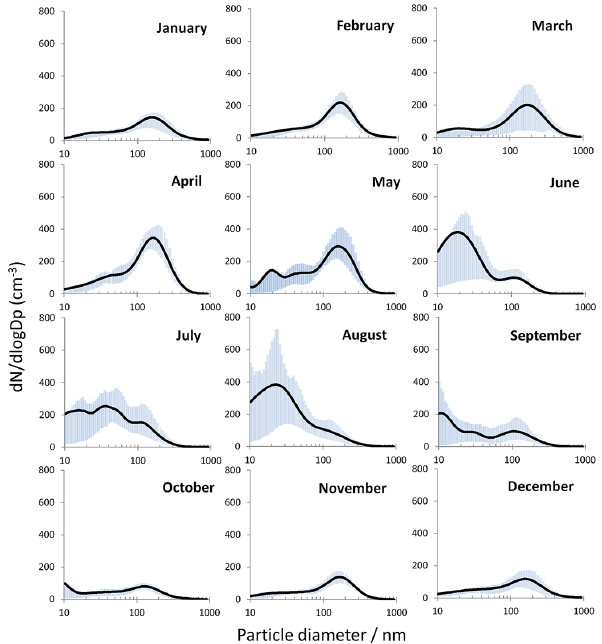
Figure 4. Monthly median particle number size distribution at Sta- tion Nord during 2012. The corresponding log-normal fitting pa- rameters are shown in Table 1. The shade area shows the 75th (up- per) and 25th (lower) percentile of the actual